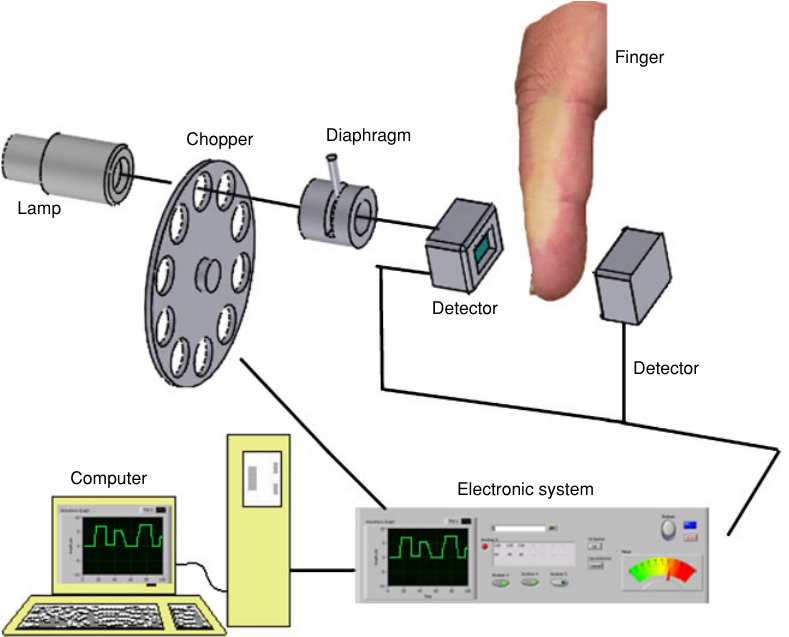
Figure 5 Diagrammatic assembly of the photoplethysmographic system.